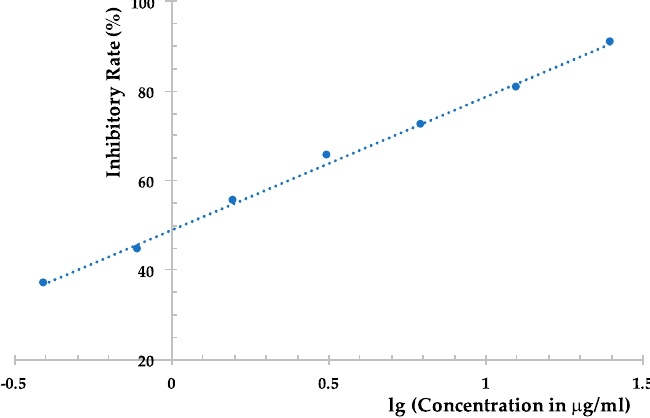
Figure 4. Dose-dependent inhibitory effect of the purified exocellular polysaccharide from the fermentation product of Phomopsis sp. FJBR-11 against TMV.